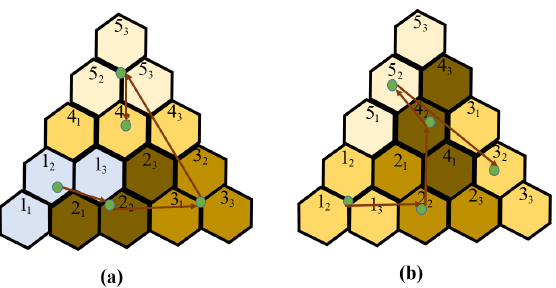
Figure 16. the optimal trajectories of CACP for two tileset in same workspace: ( a ) optimal sequence with costweight 21.19 Nm; and ( b ) optimal sequence with costweight 21.61 Nm.